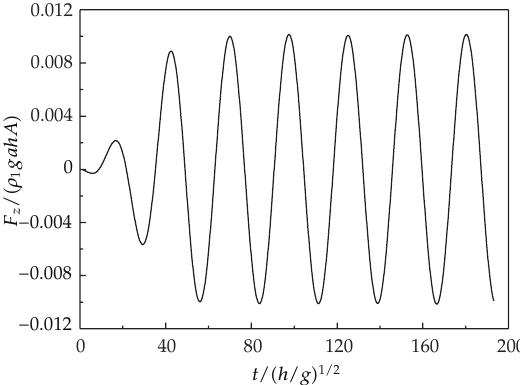
Figure 4: Time histories of vertical wave force.